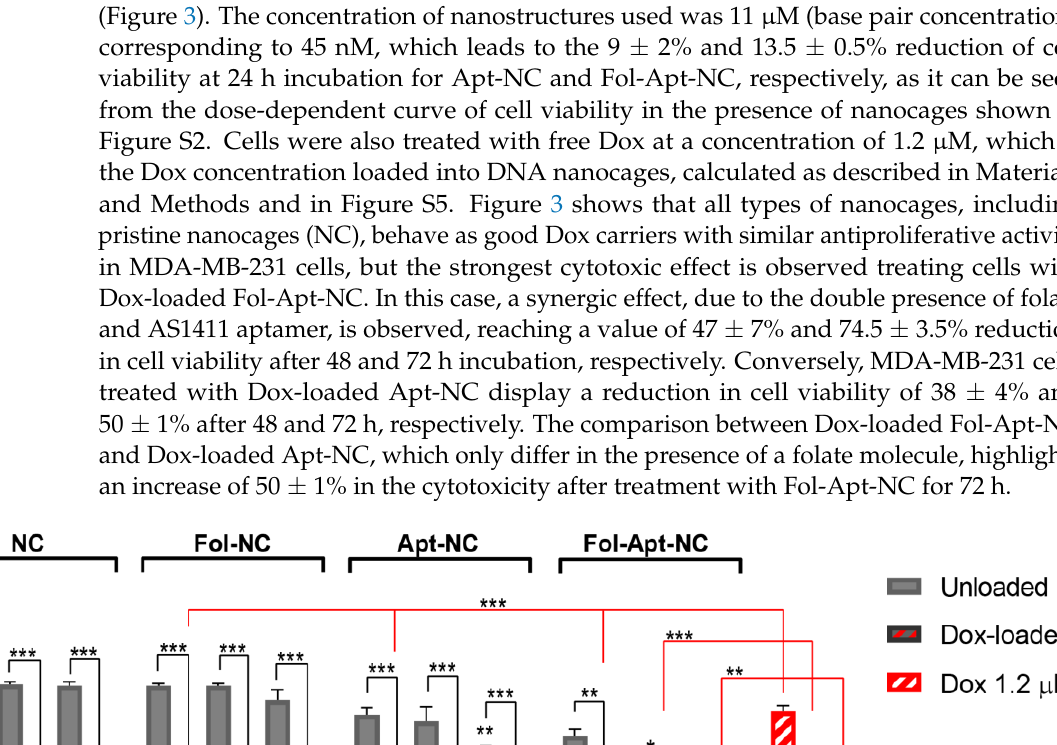
(Figure 3). The concentration of nanostructures used was 11 µ M (base pair concentration), corresponding to 45 nM, which leads to the 9 ± 2% and 13.5 ± 0.5% reduction of cell